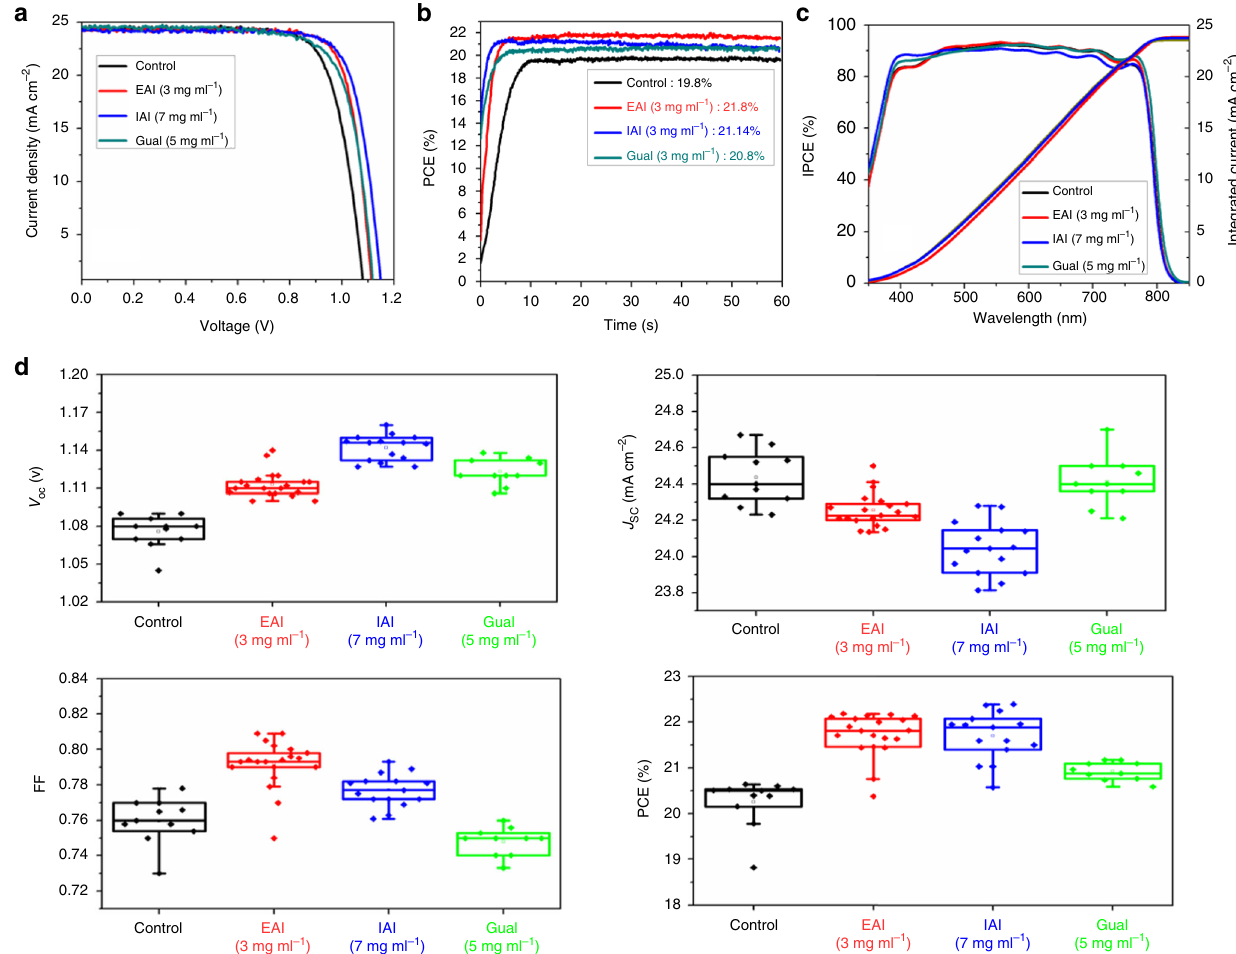
Fig. 5 Photovoltaic characterization: a J-V curves of the devices with different passivation layers in comparison to the control device without any treatment, with a scan rate of 10 mV/s b Maximum power tracking of the same device, c ) IPCE spectra and calculated photocurrent integrated over the standard AM 1.5 G solar emission. In agreement to the J-V data no change in the spectra is observed, and d J – V metrics of perovskite devices with different treatment in comparison to the control